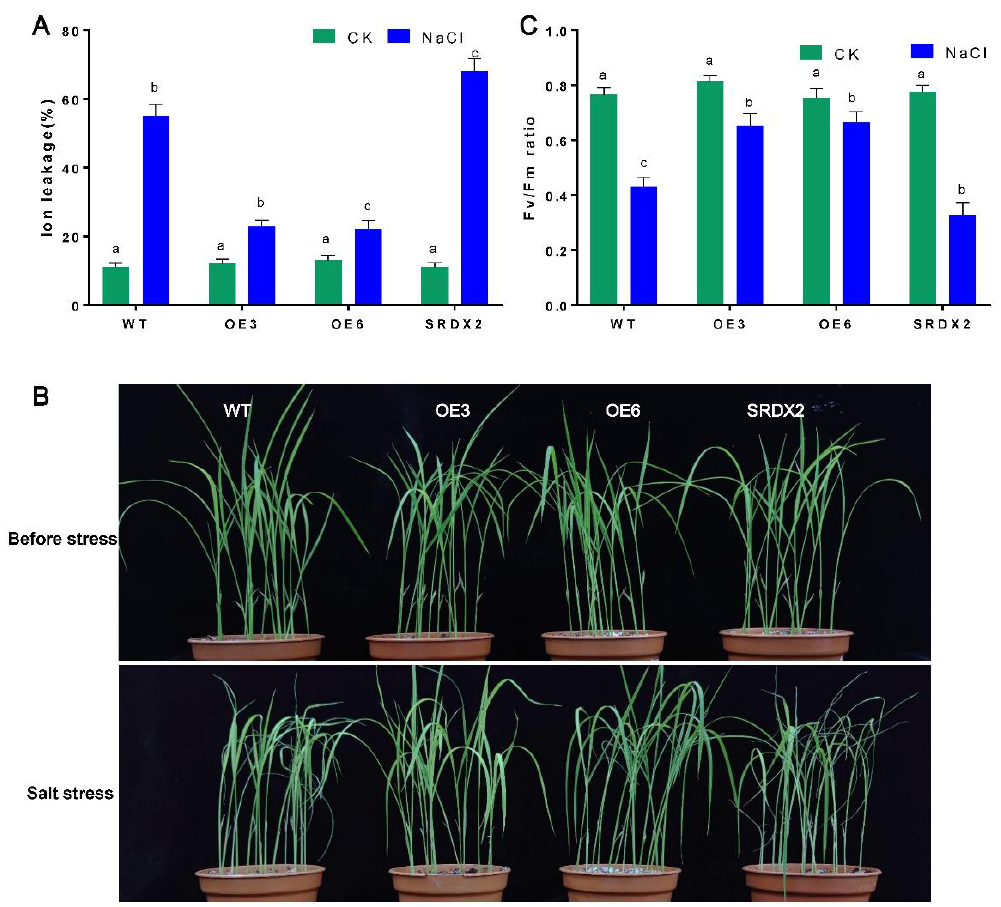
Figure 5. Effect of salt stress on WT and transgenic rice plants. ( A ) Ion leakage assay of these plants upon salt stress. Mean and SD are shown (n = 20) ( B ) Phenotypes of WT and transgenic rice plants grown in soil under normal conditions and salt stress (350 mM). Independent experiments were repeated three times. ( C ) Fv/Fm of rice plants. The 21-day-old rice seedlings grown under the control and salt-stress (200 mM NaCl) conditions for 4 days. Mean and SD are shown (n = 20). Statistical analyses were performed by a two-way ANOVA, followed by a Tukey’s multiple comparison test. Different letters indicate significant differences at p < 0.05.